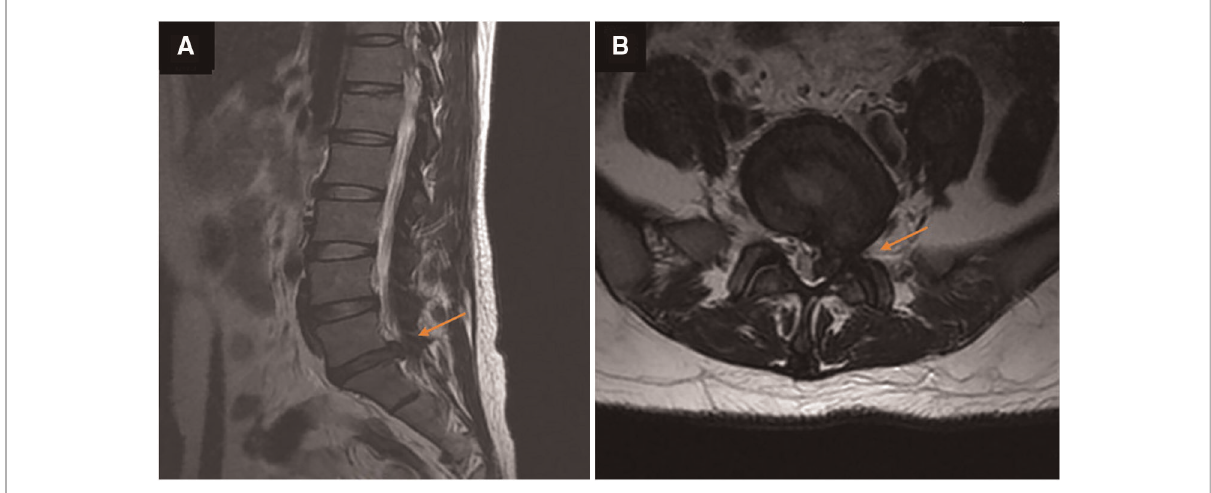
FIGURE 1 Magnetic resonance images of the lumbar before percutaneous endoscopic lumbar discectomy (PELD) in axial ( A ) and sagittal ( B ). a large disc herniation with compression of the spinal cord and nerve roots at the left of